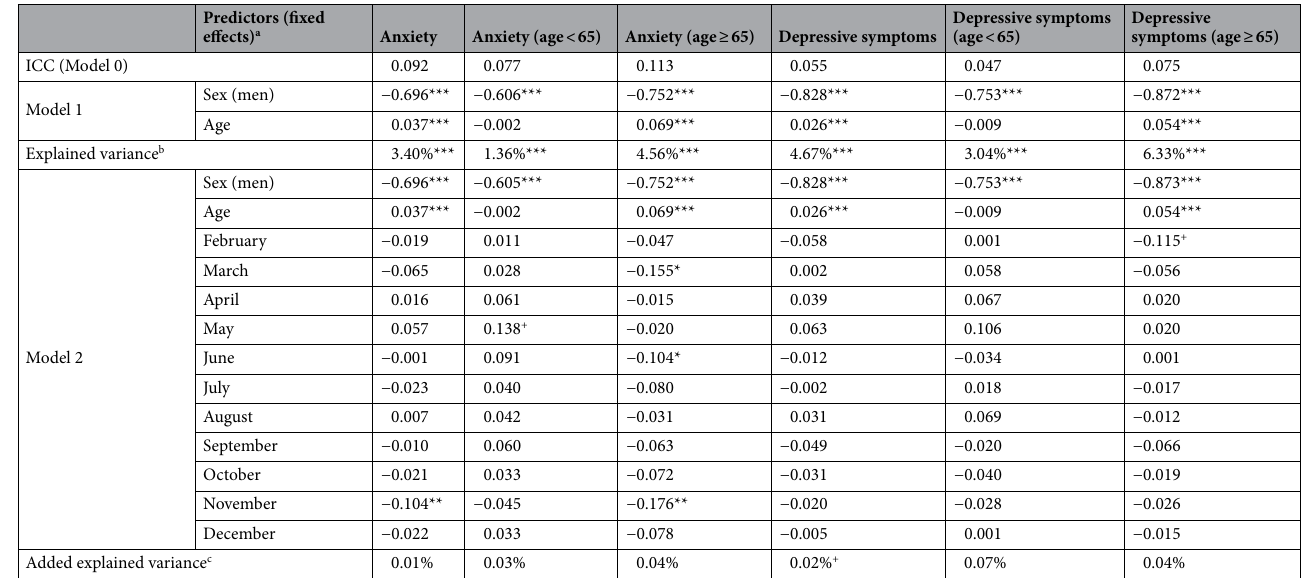
Table 2. Multilevel models predicting anxiety and depressive symptoms with months of birth adjusted for sex and age. ICC = intraclass correlation, i.e., variance attributable to cluster (country) differences. a The models are clustered across countries. b Added explained within country residual variance of the fixed effect of sex and age in comparison to Model 0. Model 0 is the unconditional model splitting the variance of the dependent variable into within cluster and between cluster parts. c Added explained within country residual variance of the fixed effects of birth months in comparison to Model 1. + p < 0.1; *p < 0.05; **p < 0.01; ***p <